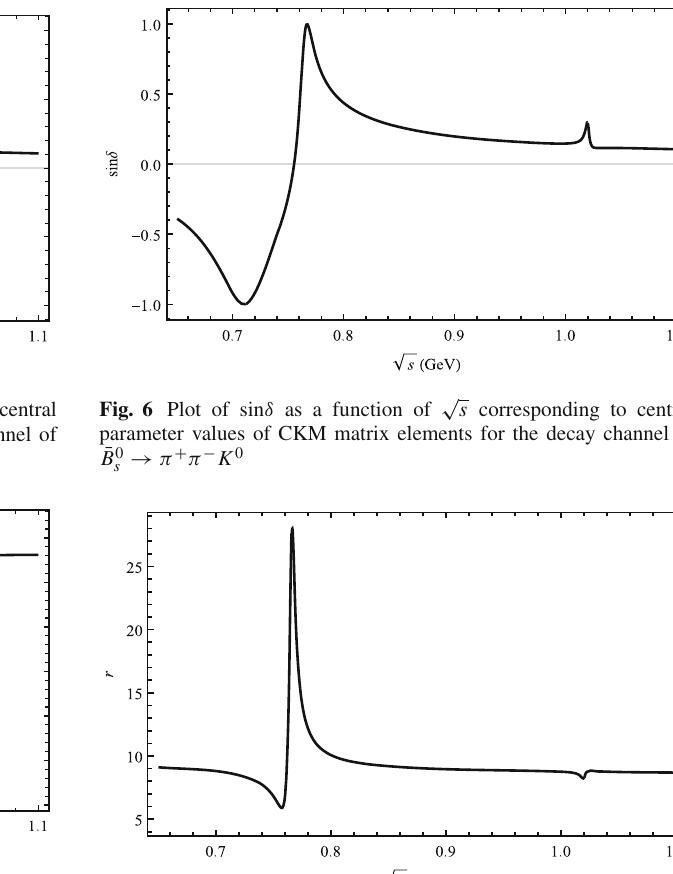
Fig. 2 Plot of A CP as a function of parameter values of CKM matrix elements for the decay channel of ¯ B 0